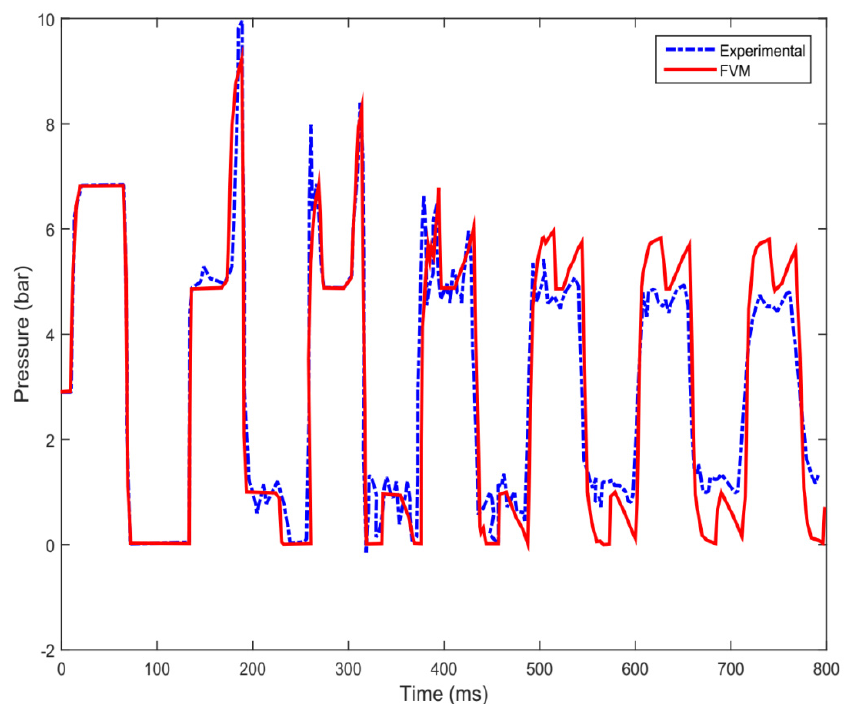
Figure 13. Comparison between numerical solutions and experimental data with the presence of moderate void fraction in a pipe [87].